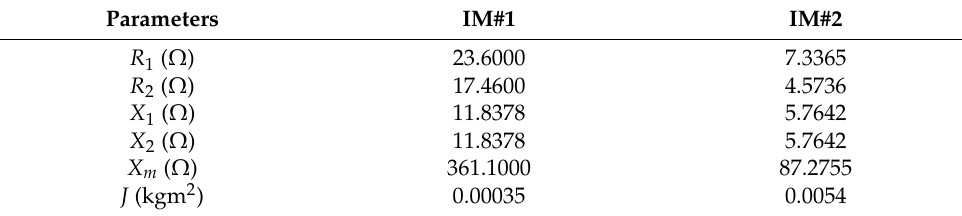
Table 1. Calculated equivalent circuit data.